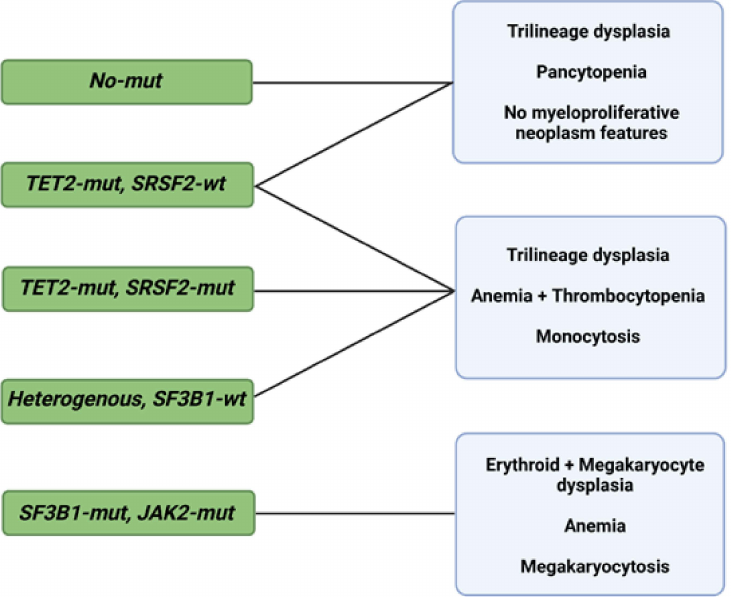
Figure 2. Morphological profiles and associated genetic signatures. Representation of prognosti- cally significant groups according to mutations, morphologic phenotypes, and their combination. Abbreviations: mut, mutation; wt, wild type; TET2, ten-eleven translocation 2; SRSF2, serine and arginine rich splicing factor 2; SF3B1, splicing factor 3b, subunit 1; JAK2, Janus kinase 2. Modified from Nagata et al. [69]. BioRender was used to make the figure.